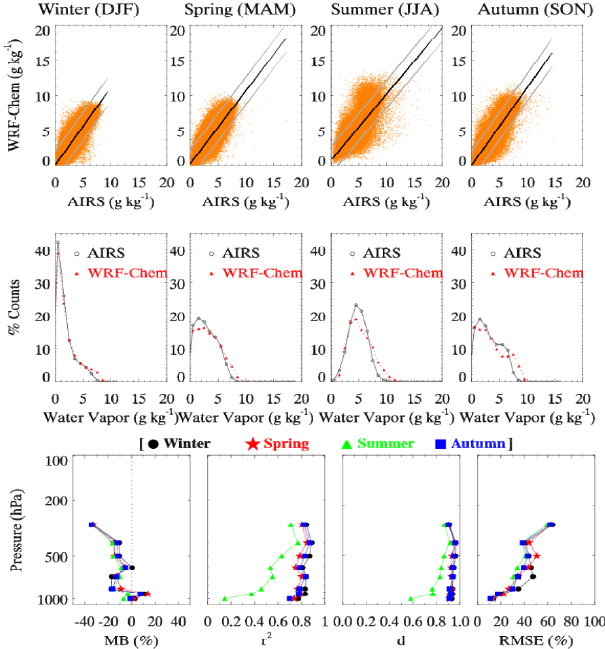
Figure 6: The scatter plots (top panel) and the frequency analyses (middle panel) of AIRS and model water vapor at 1 g kg -1 interval for 700 hPa during the four seasons of the year 2008. The black lines in the scatter plots represent the linear fit to the data while the grey lines are the 95% confidence interval estimates in the fitted values. The vertical profiles (bottom panel) of MB, r 2 , d and RMSE for each season are also shown. AIRS water mixing ratio. The values of both r 2 and in- dex of agreement in summer ( r 2 : 0.14–0.77; d : 0.58–0.92) are significantly lower than those in any other season ( r 2 :